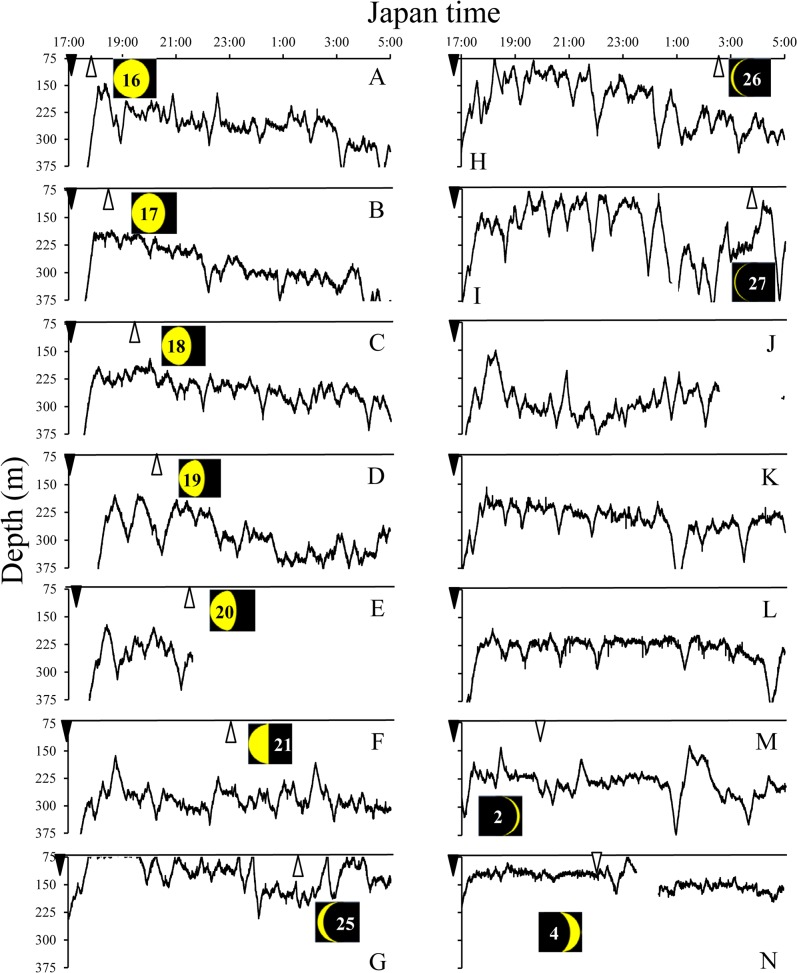
Vertical movement profiles (black lines) of five wild eels and lunar cycle during nighttime (17:00–5:00) in KC area.A-E, WE6285 (November 29—December 4). F, WE6288 (December 5–6). G-L, WE6289 (December 8–14). M, WE6287 (December 16–17). N, WE6286 (December 18–19). Moon phase is shown in the black quadrangle and is indicated by the number. Sunset (inverted closed triangle), moon rise (open triangle) and moon set (inverted open triangle).